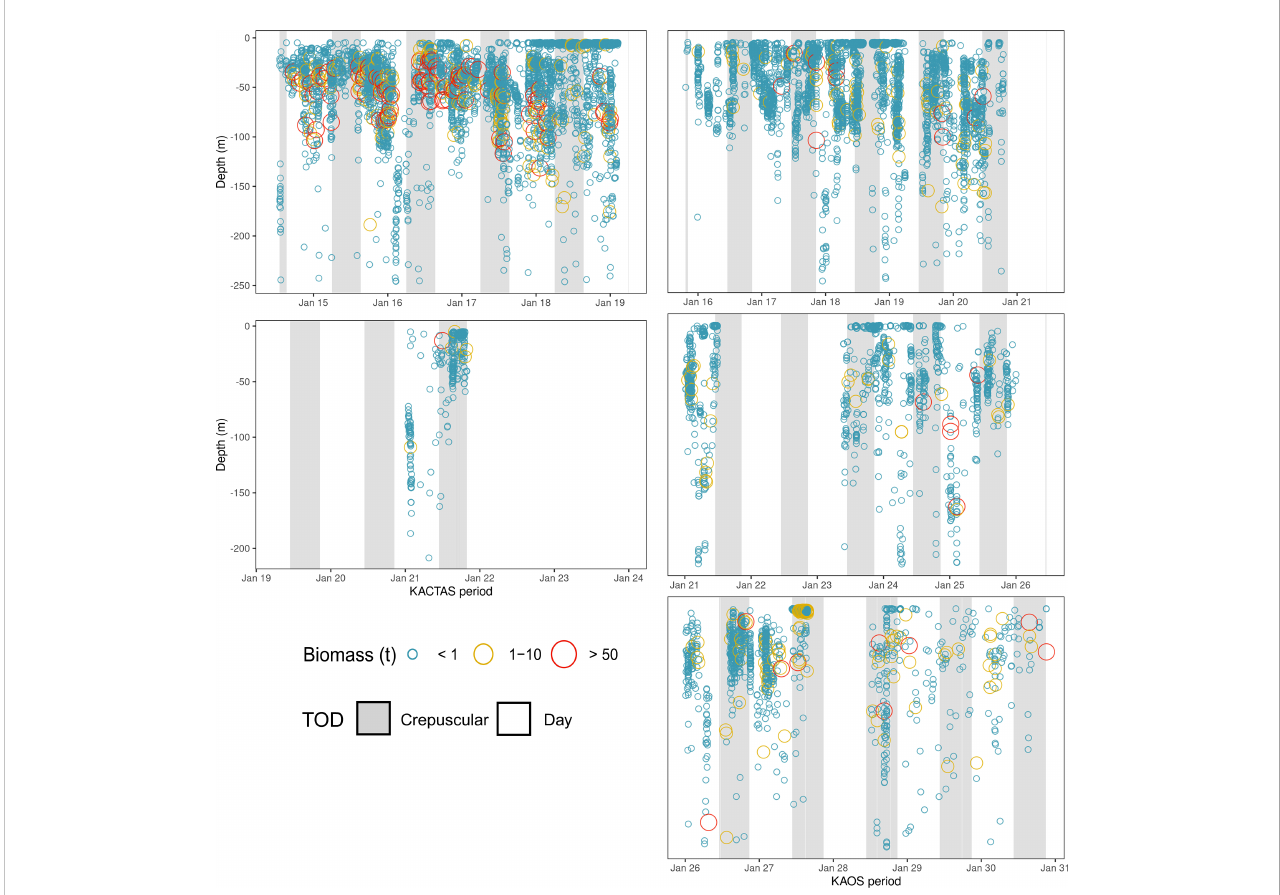
FIGURE 3 Time-series showing krill swarm distribution through time for KACTAS and KAOS (left and right panels, respectively). Each panel represents a vertical snapshot of the water column (0 – 250 m) over a speci fi c period of time during survey efforts. Each circle represents a krill swarm observed and are sized and coloured in relation to their biomass values (see Methods for details). To aid visual presentation, biomass estimates are grouped into discrete categories. Shaded areas represent the diurnal period in which krill swarms were observed. Using the ‘ maptools ’ package, we calculate the solar position values during survey effort period (Bivand and Lewin-Koh, 2016). Solar positions values > 12° were assigned as day and those between -12° and 12° were assigned as crepuscular; at this time of year there are no night (< -12°)